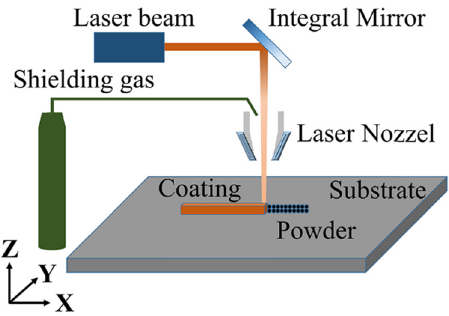
Figure 1: Processing